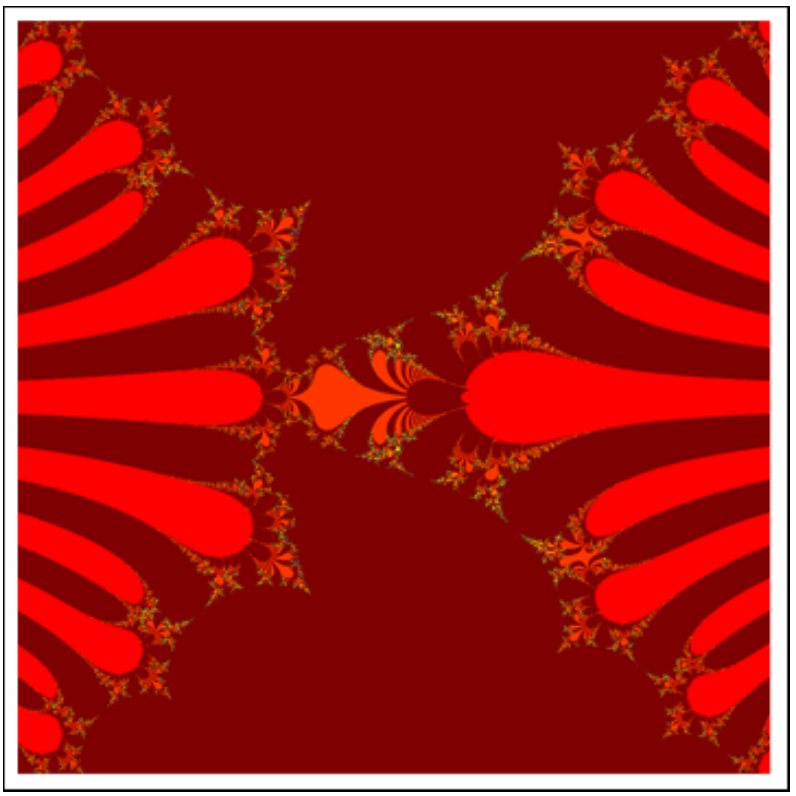
Figure 34. M-set for τ ( z ) = e z 2 + c via DKIS. The image execution time is 504.88 s.